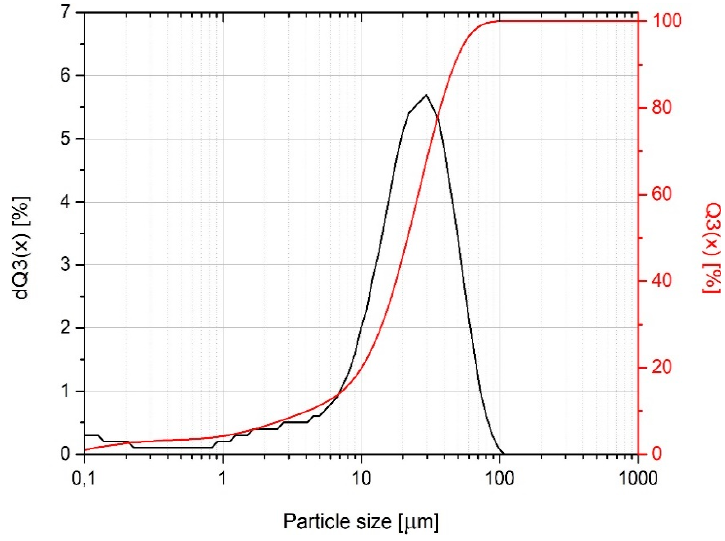
Figure 4. The particle size distribution of bentonite used as a filler.